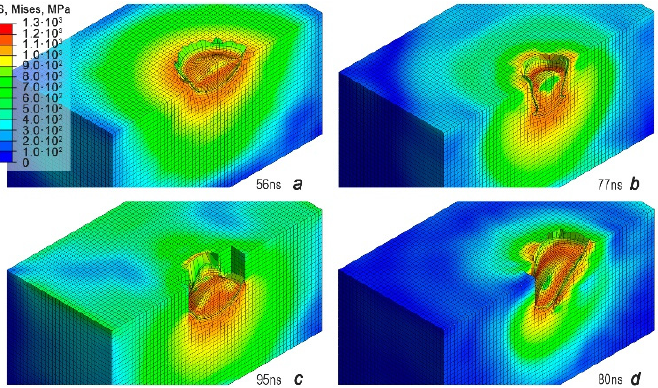
Figure 5. The von Mises stress distribution in the particle ( d P = 50 µ m) and substrate material at the end of the collision: ( a ) without microdefect; ( b ) with cube-shaped microdefect; ( c ) with rectangular-shaped microdefect; ( d ) particle collision on the edge of cube-shaped microdefect.